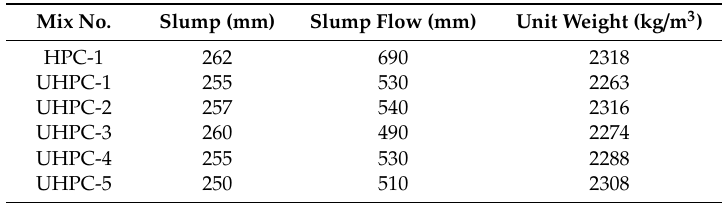
Table 7. Results of fresh concrete properties.